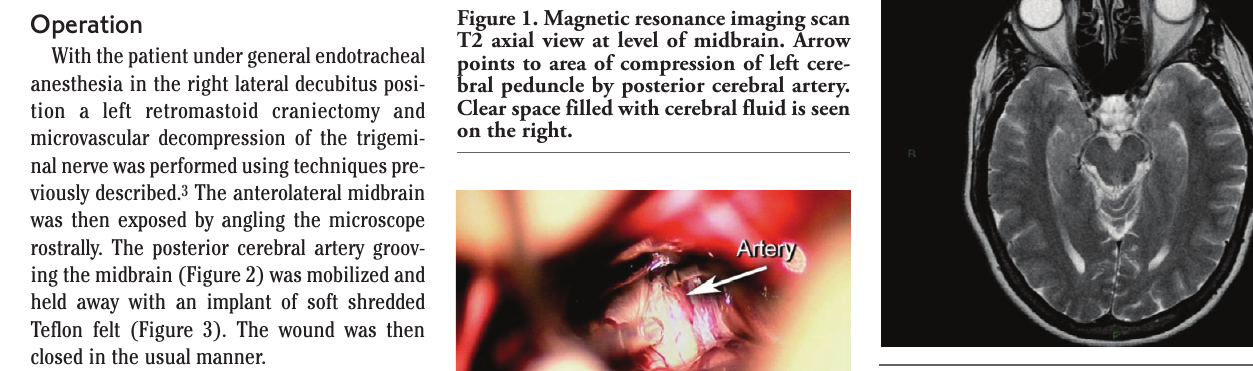
Figure 5. Magnetic resonance imaging T2 axial view at the level of midbrain in con- trol patient without Parkinson Disease. Note that posterior cerebral arteries do not impinge upon cerebral peduncle. A clear space filled with cerebrospinal fluid is seen bilaterally.